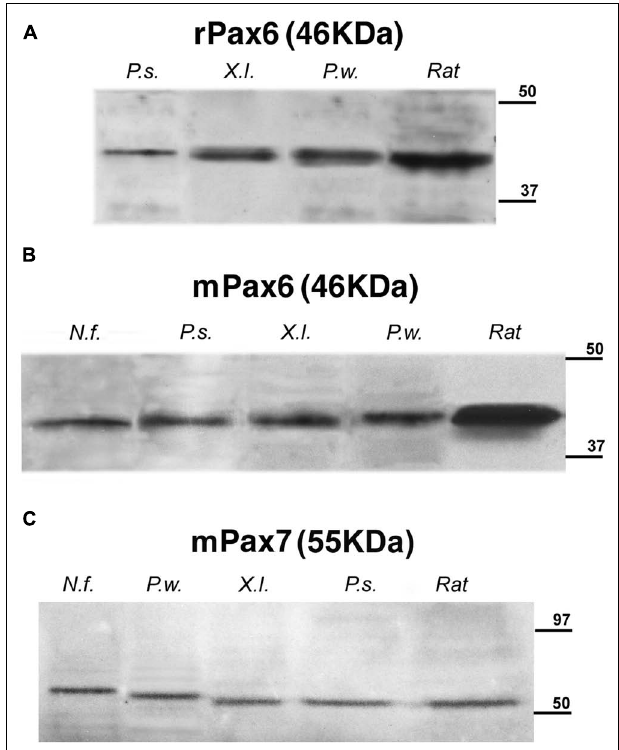
FIGURE 2 | Identification byWestern blots of protein bands recognized by the used antibodies: (A) rabbit anti-Pax6, (B) mouse anti-Pax6, and (C) mouse anti-Pax7. A single band is seen in each of the lanes corresponding to the Neoceratodus forsteri ( N.f. ), Pseudemys scripta ( P.s. ), Xenopus laevis ( X.l .), and Pleurodeles waltl ( P.w. ) brain extracts that are compared with the band stained in each case for rat brain extracts.The expected molecular weight is indicated for each transcription factor, and the molecular weight standard is represented at right in each photograph.